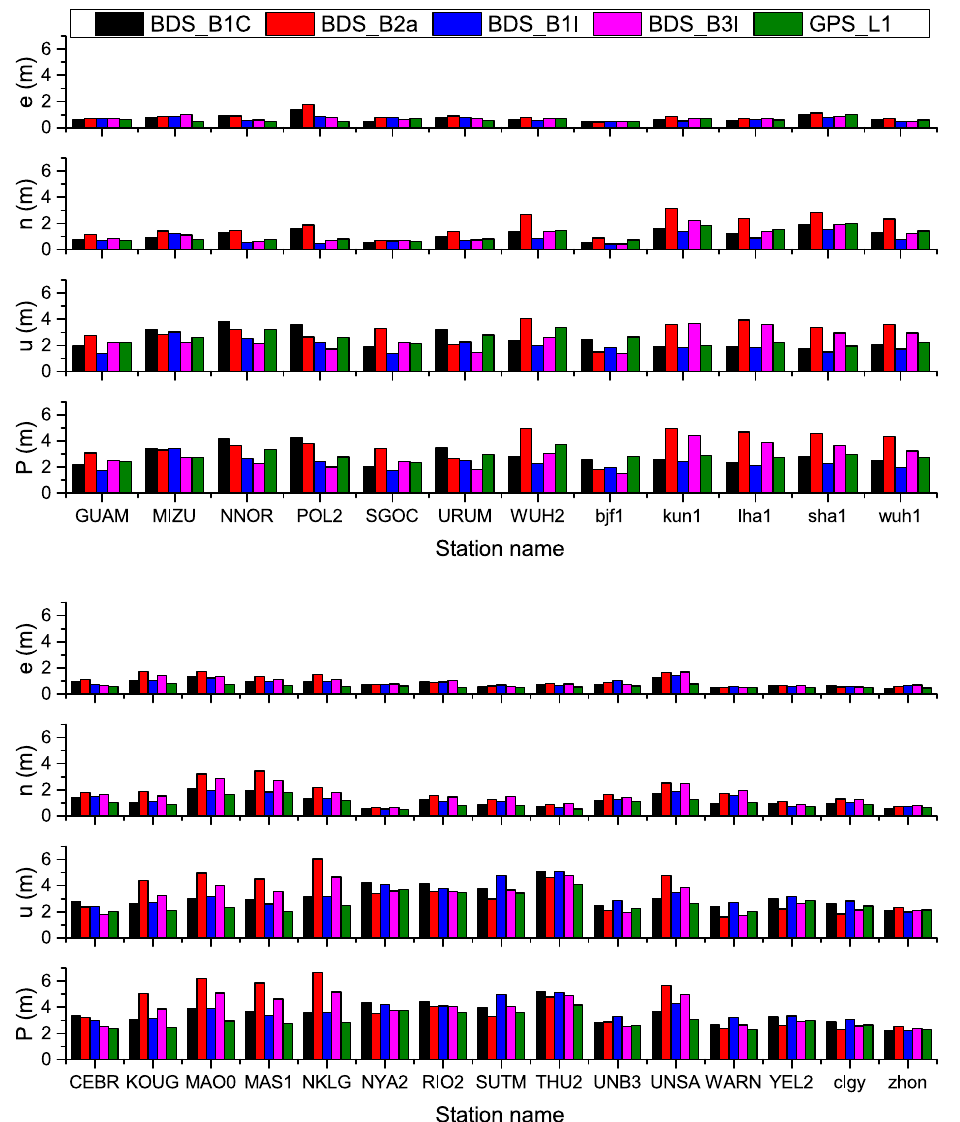
Figure 8. RMS statistics of single-frequency SPP positioning errors for stations in the Asian-Pacific region (top) and other regions (bottom). The MGEX station names are in the capital letters and the iGMAS station names are in the lowercase letters.